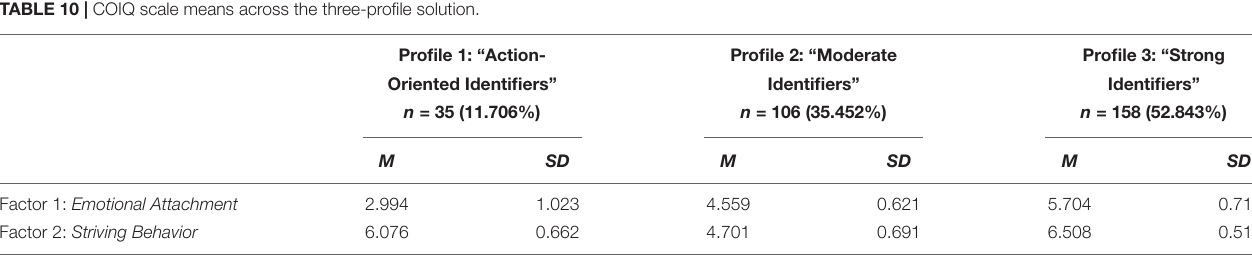
TABLE 10 | COIQ scale means across the three-profile solution. Profile 1: “Action- Profile 2: “Moderate Profile 3: “Strong Oriented Identifiers”